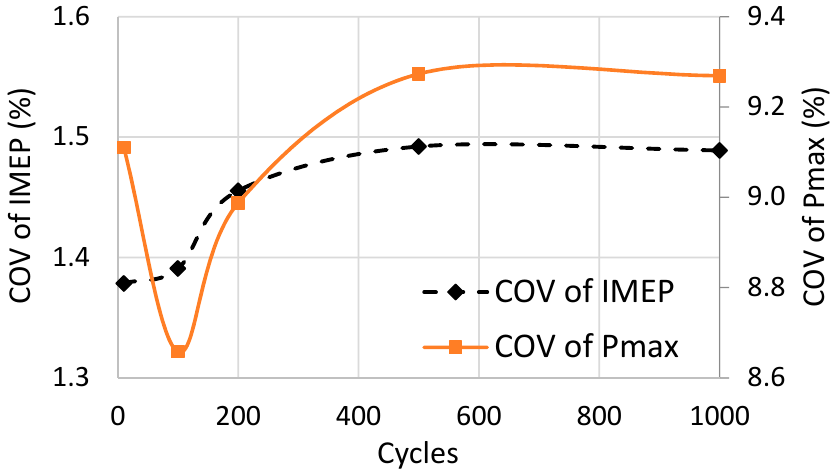
Figure 4. Coe ffi cient of variation (COV) of IMEP and peak pressure for a di ff erent number of Figure 4. Coefficient of variation (COV) of IMEP and peak pressure for a different number of cycles.